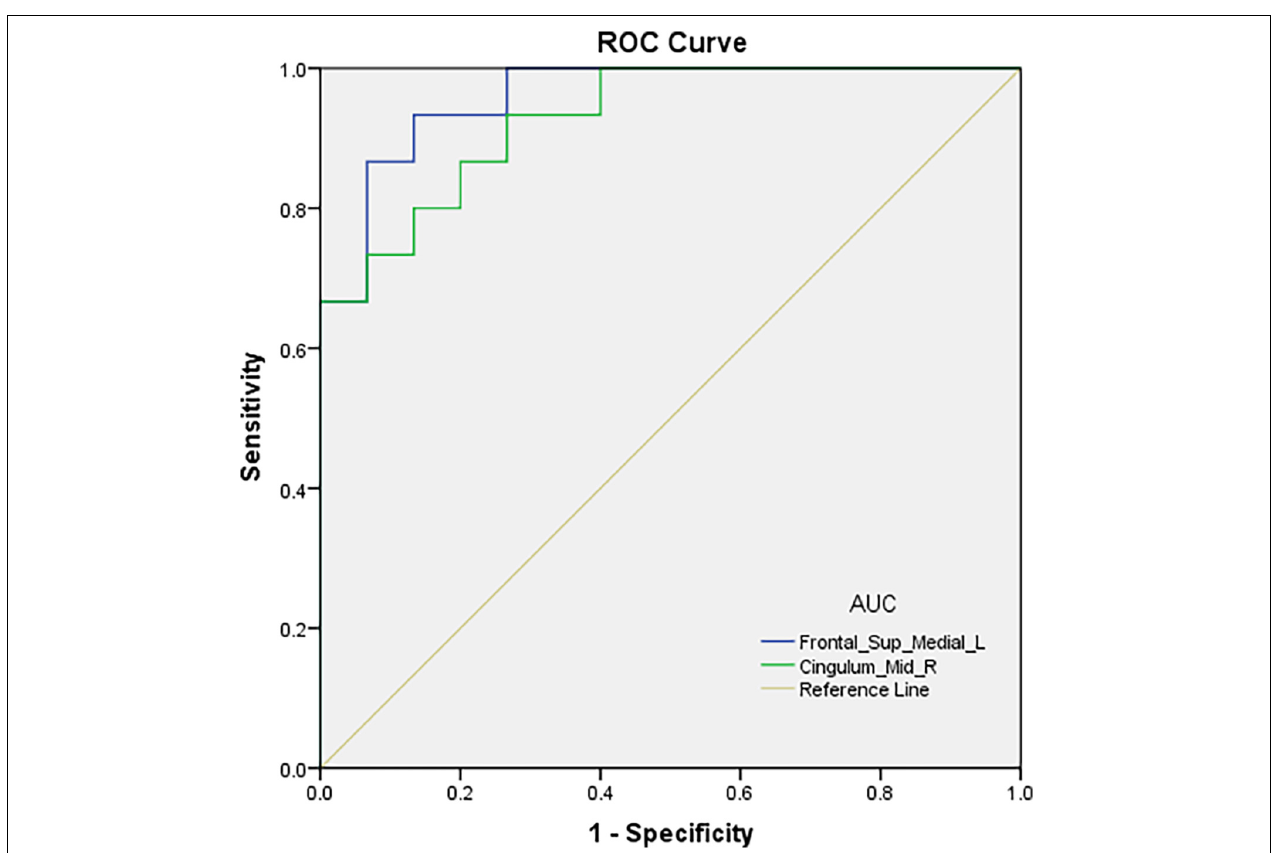
FIGURE 3 | ROC curve analysis of the fALFF values for altered brain regions. The area under the ROC curve were 0.960, ( p < 0.001; 95% CI: 0.899-1.000) for Frontal_Sup_Media l_L, and 0.929, ( p < 0.001; 95% CI: 0.843-1.000) for Cingulum_Mid_R.